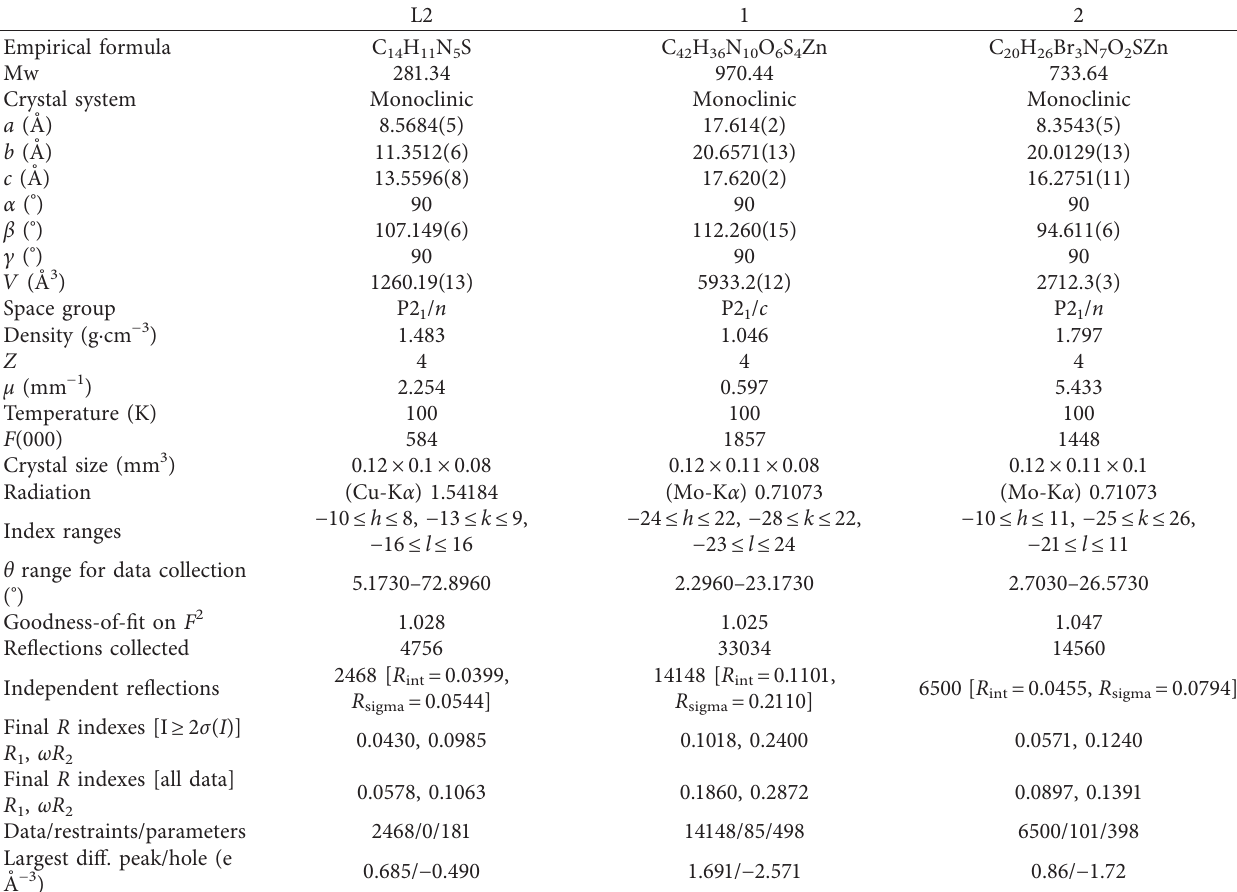
Table 1: Crystallographic data and structure refinement summary for ligand L2 and complexes 1-2. L2 Empirical